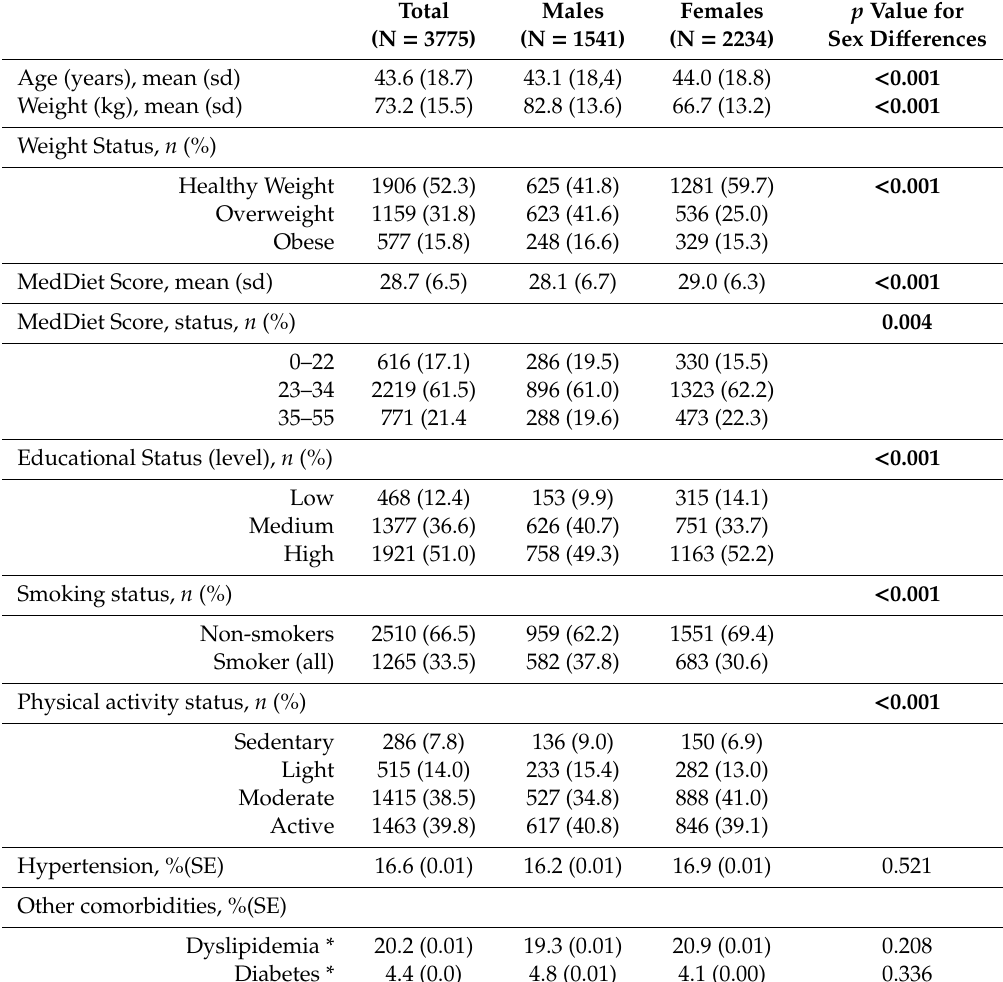
Table 1. Demographic characteristics of the HNNHS study’s adult participants by